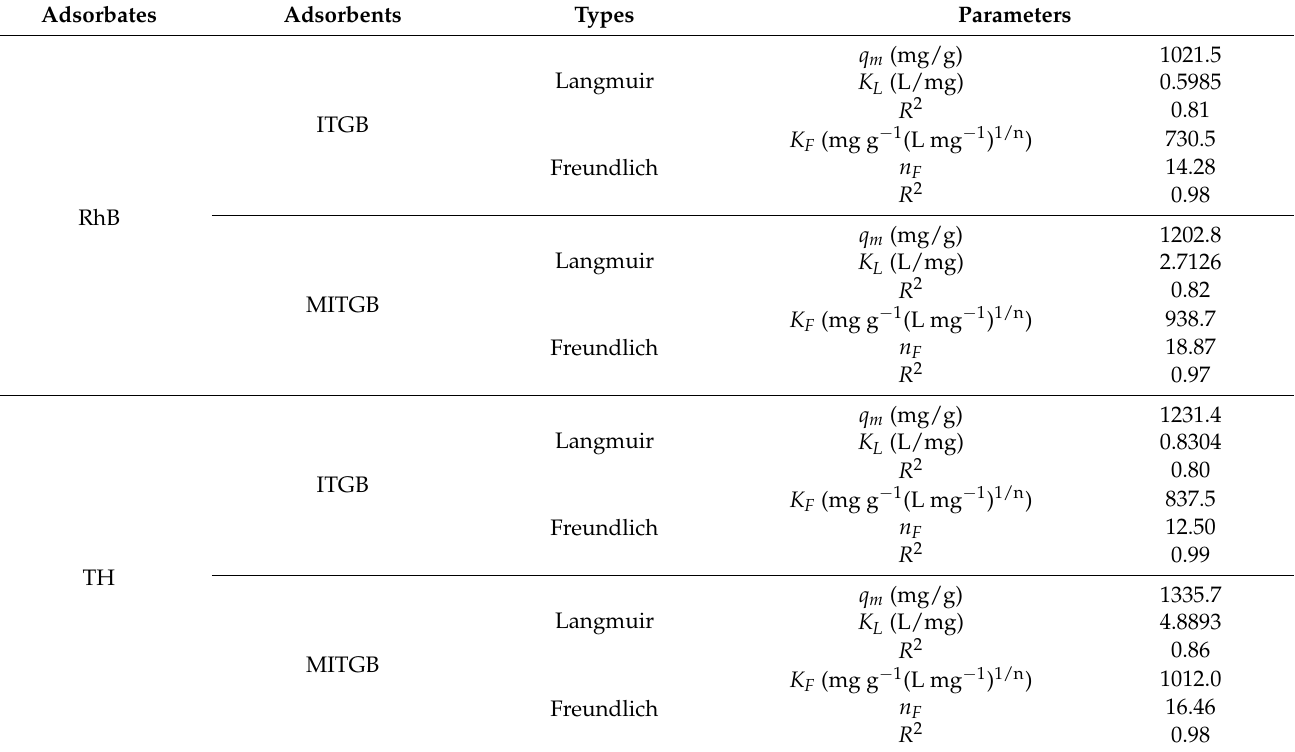
Figure 6. Langmuir and Freundlich isotherms of RhB and TH for ( A ) ITGB and ( B ) MITGB at 303 K. Table 3. Fitting parameters of adsorption isotherm models for RhB and TH at 303 K.